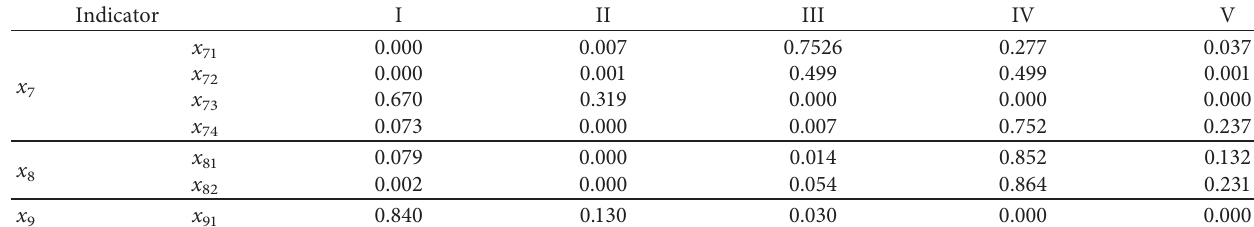
Table 9: Membership degree of social vulnerability indicators.